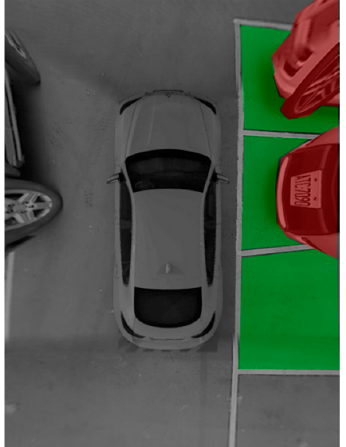
Figure 14. Features of a parking space.